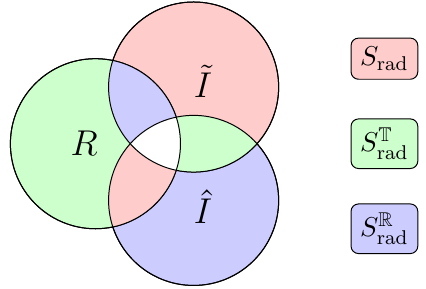
Figure 3 . The contributions to S QFT ( R ∪ I ) as determined by the overlaps of the three subsets of I + labelled R , ˜ I and ˆ I . Note that the triple intersection does not contribute because the modes in the 3 subsets together are in a pure